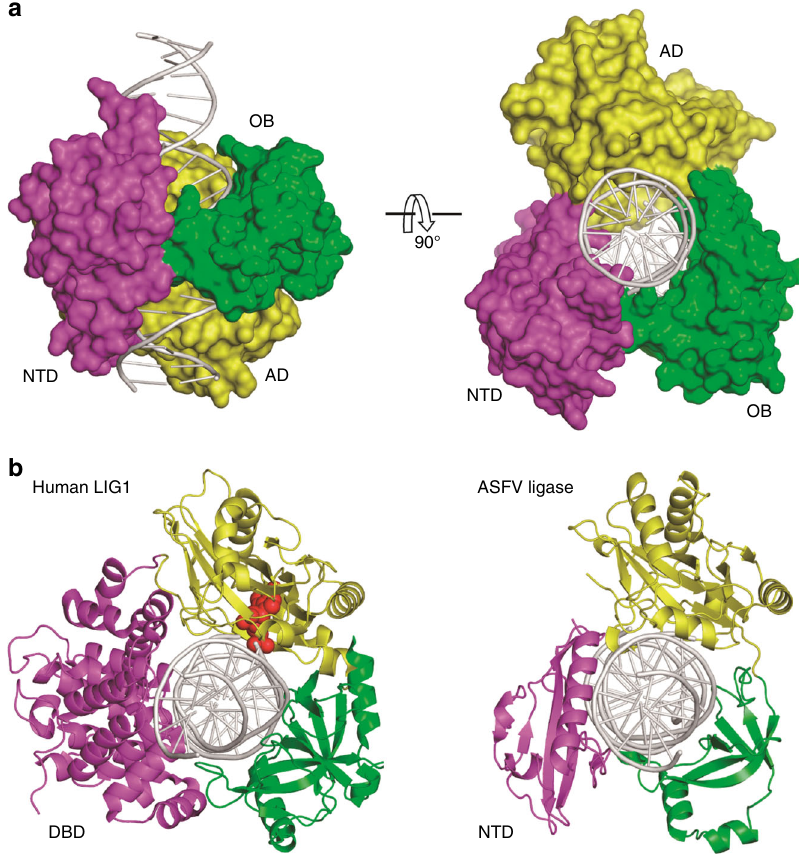
Fig. 2 The catalytic Asfv LIG:DNA complex structures. a The overall structure of Asfv LIG:CT1 complex demonstrating the arrangement of individual domains in the catalytic form complex. Asfv LIG and DNA are shown as surface and cartoon, respectively. b Comparison of the catalytic form complexes of Asfv LIG and Hs LIG1 (PDB_ID: 1 × 9 N). DNAs are colored in white, whereas the ligase NTD (or DBD), AD and OB domains are colored in magenta, yellow and green, respectively. In the Hs LIG1 structure, the AMP that pyrophosphate linked to the 5 ′ -P downstream of the DNA is shown as red (Fig. 3d). T8 and G9 are located in the middle of the DNA duplex. Via direct or water-mediated H-bonding (Fig. 3e), the neighbor- ing G6 and A7 of the upstream DNA interact with Lys85 and Asn86 of the β 7- α 3 connecting loop (residues 82-94); the H-bond distances are all within the range of 2.7 – 3.1 Å. The β 7- α 3